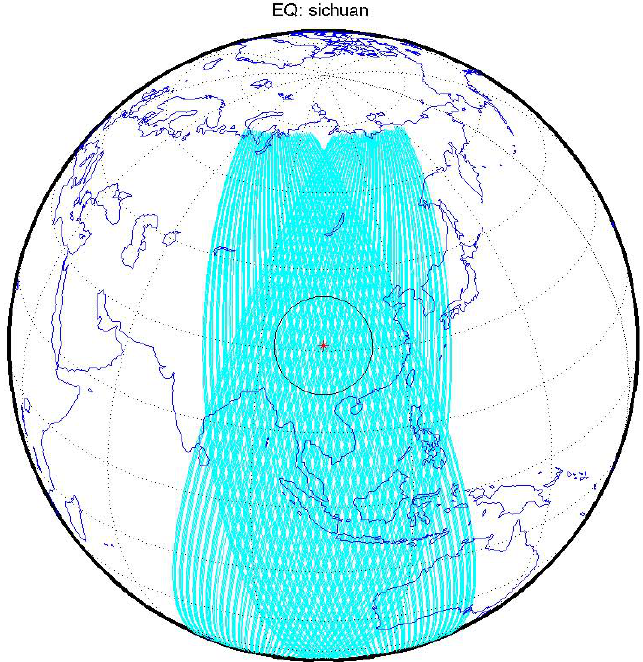
Fig. 1. DEMETER data coverage around the time of the Sichuan earthquake. The cyan lines trace the orbital trajectories that pass closest to the earthquake epicentre (indicated by the red star). The black circle encloses a region of radius 1000km centred in the epicentre position.